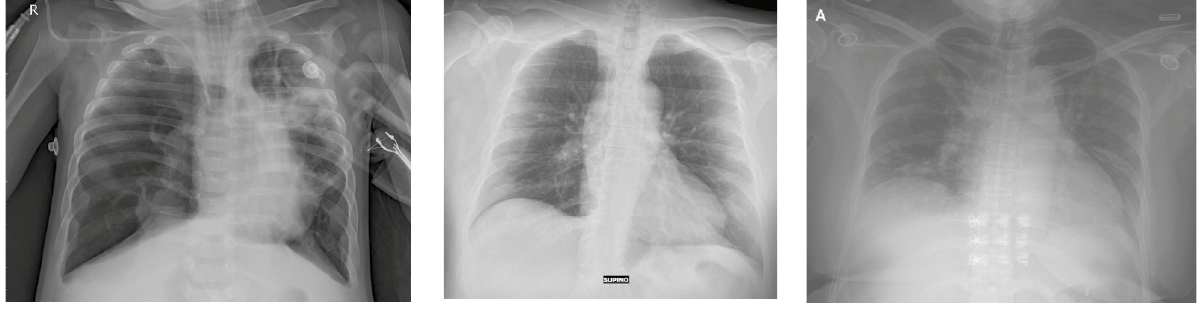
Figure 5. Examples of bias associated with the patient’s